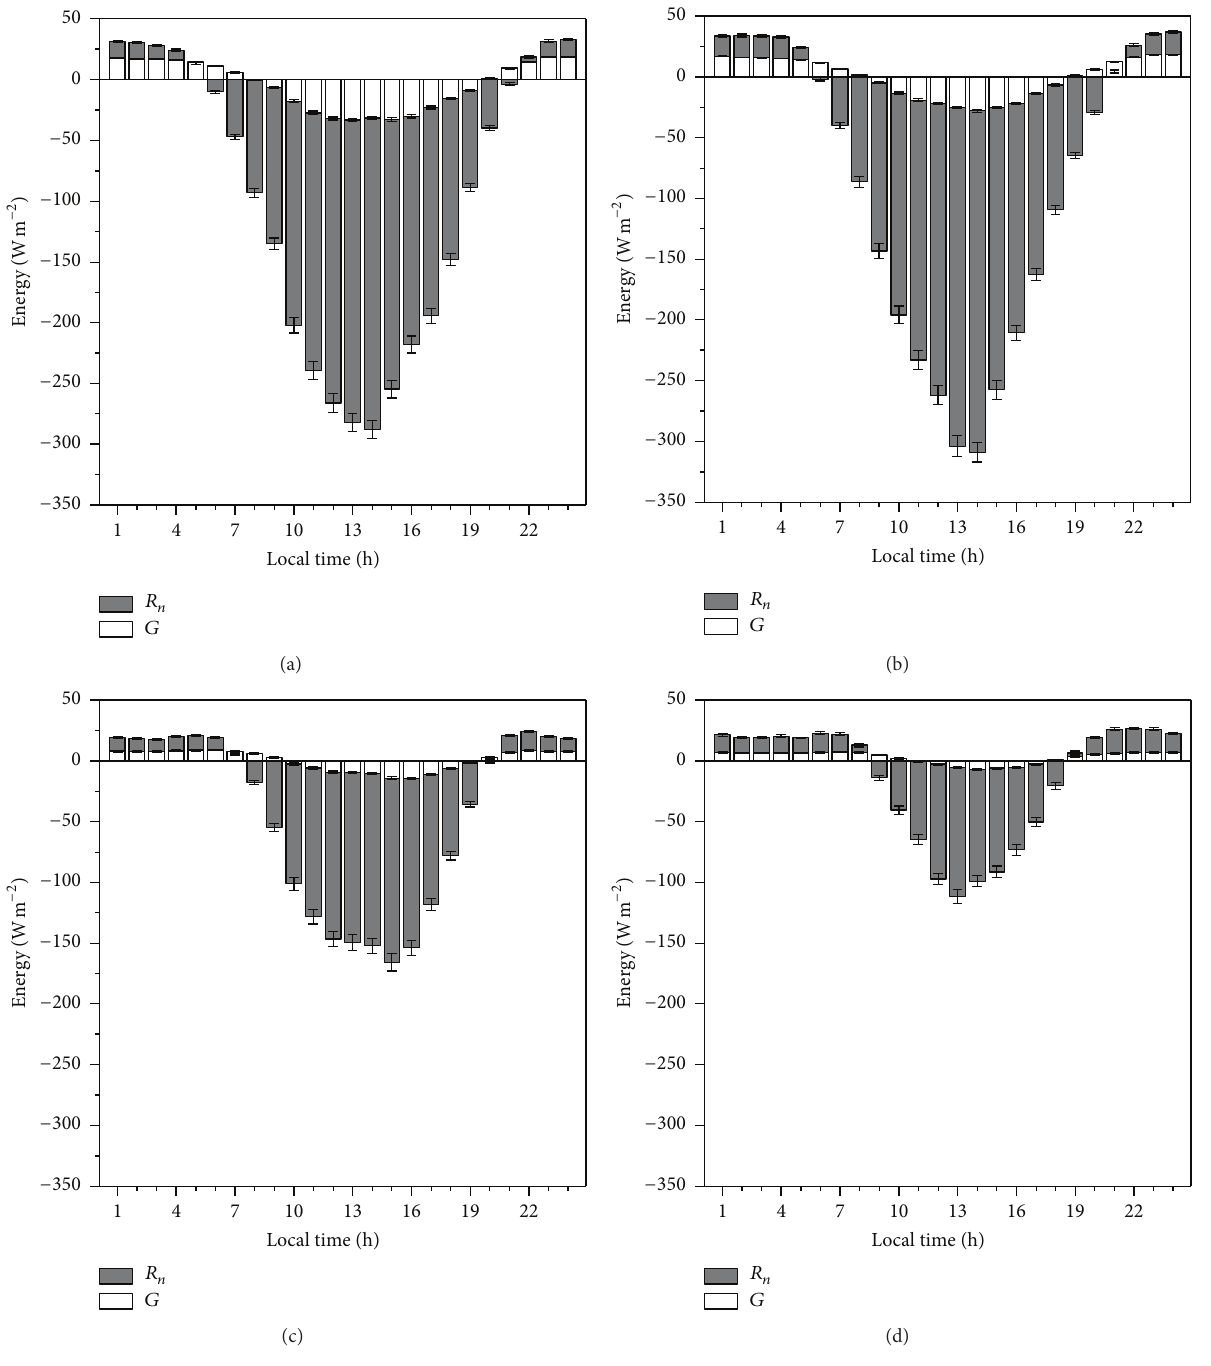
Figure 5: Diurnal variation of hourly average net radiation ( 𝑅 𝑛 ) and soil heat flux ( 𝐺 ) for (a) Dec 2013, (b) Jan 2014, (c) Feb 2014, and (d) Mar 2014. The vertical bars indicate the standard